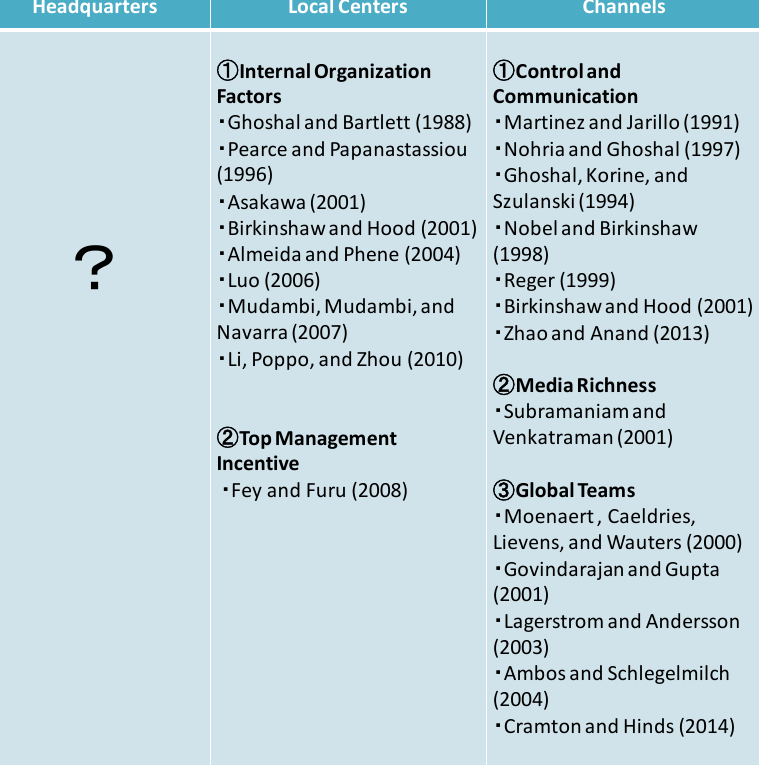
categories (i.e., headquarter organizational factors, local units organizational factors, and channels connecting headquarters and